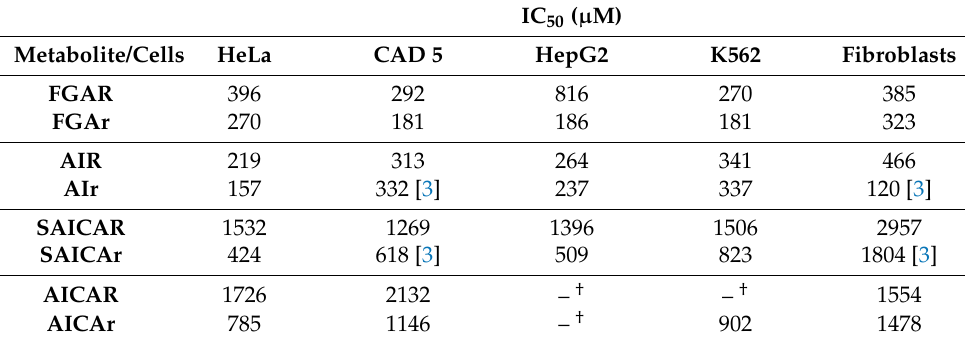
Table 1. IC 50 values of DNPS